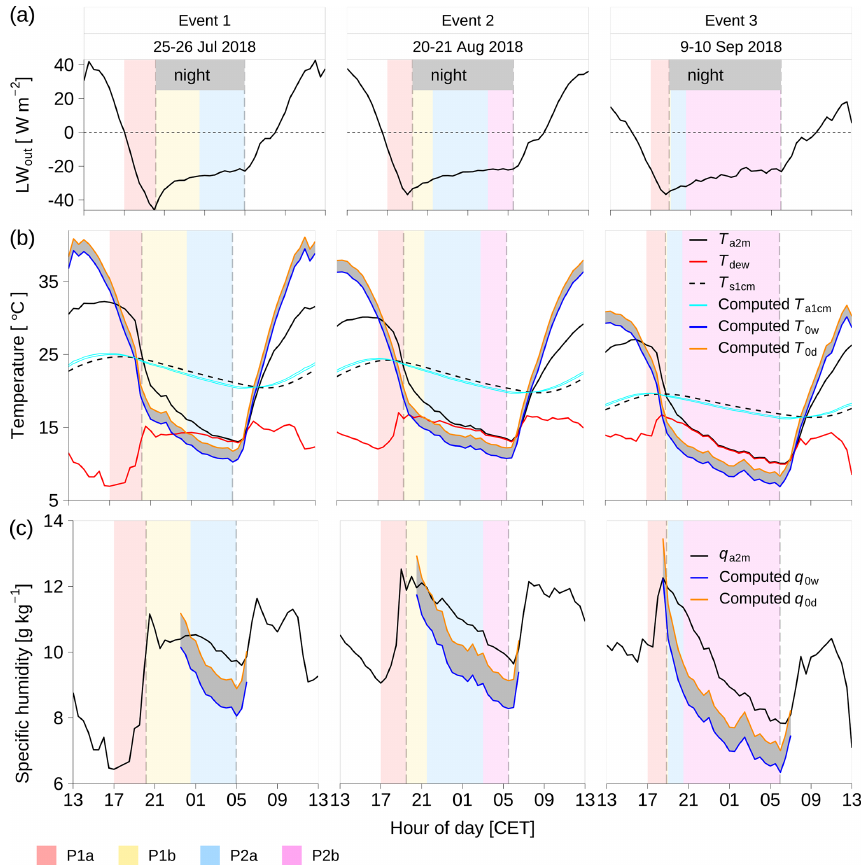
Figure 5. The atmospheric and surface conditions at the Chamau site: (a) LW out , long-wave outgoing radiation. (b) T a2m , air temperature at 2ma.g.l.; T d , dew-point of the ambient air; T 0w and T 0d , computed wet and dry surface temperature; T s1cm , soil temperature at 1cm below ground; T a1cm , computed air temperature at 1cma.g.l. (c) q a2m , atmospheric specific humidity at 2.4ma.g.l.; q 0w and q 0d , computed saturation specific humidity with respect to wet surface temperature T 0w and dry surface temperature T 0d . Vertical dashed lines show local sunset and sunrise times. The shaded areas indicated different periods of environmental conditions as described in Sect. 4.1. The P1a period was from around 17:00CET until sunset with the weakening of turbulence and the increase of specific humidity; the P1b period was from sunset until the first sign of condensation with short-term fluctuations of specific humidity; the P2a period was the dew formation period in the conditions of relative humidity < 100%; the P2b period was the combined dew and radiation fog period in the conditions of relative humidity =